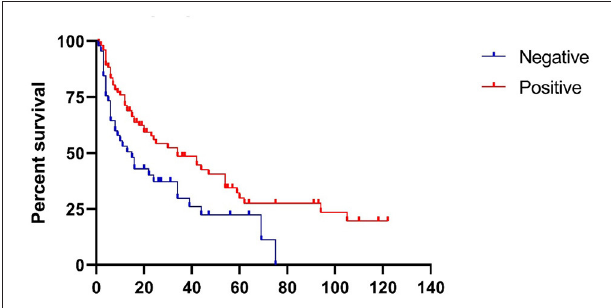
FIGURE 2 | Survival proportions: Survival of ITG treatment patients with different head thrust test results.